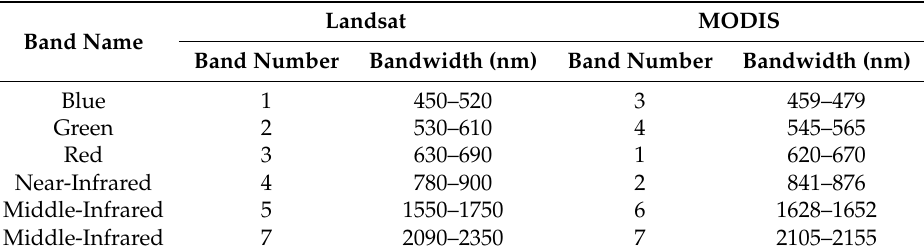
Table 2. Bandwidth of Landsat and